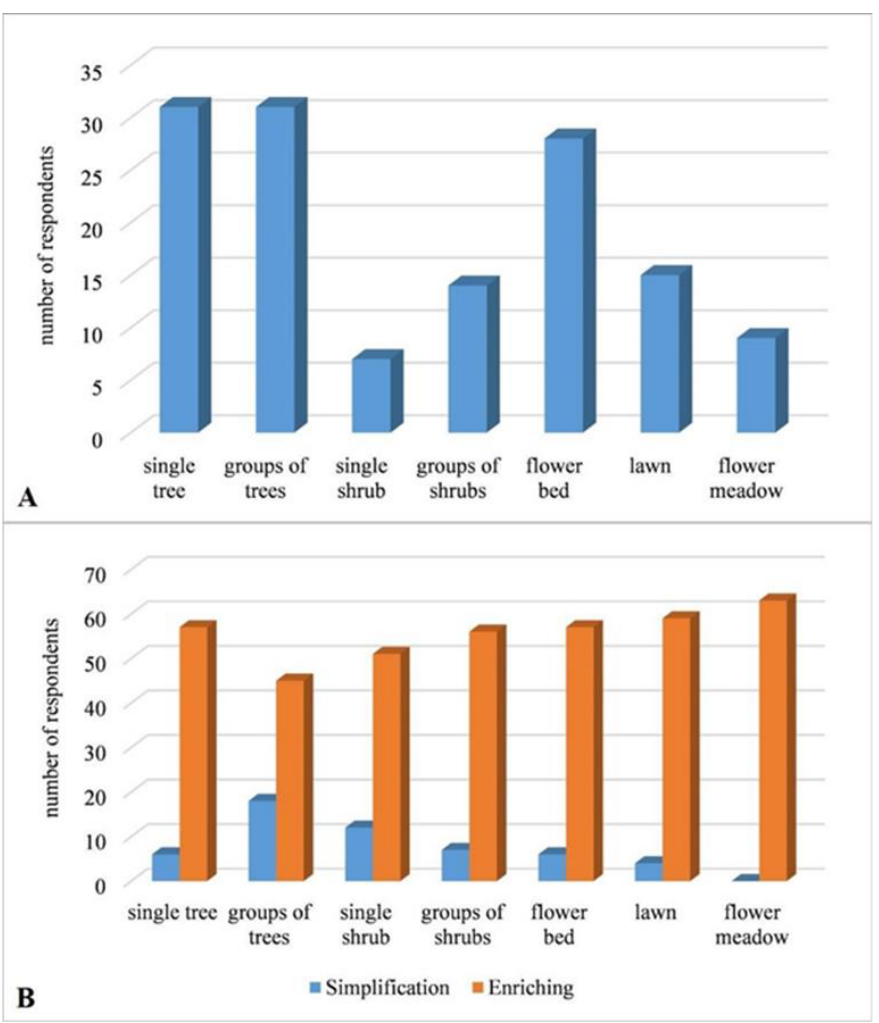
Figure 2. Changes in the composition of greenery observed ( A ) and expected ( B ) by the respond- ents.